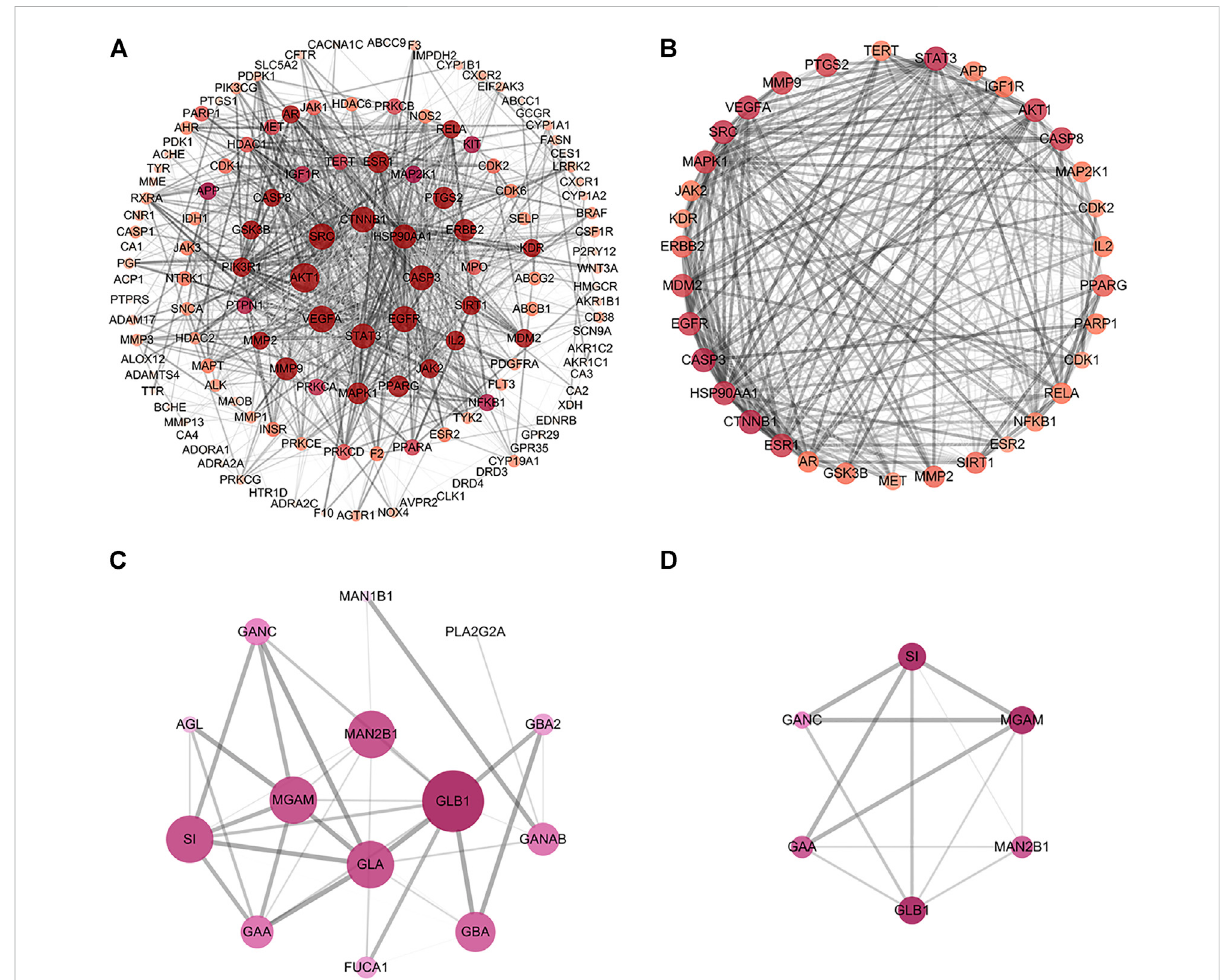
FIGURE 6 ConstructionofthePPInetworkandcoretargets. (A) ThePPInetworkofpotential proteintargetsofMLFinthetreatmentofT2DMconstructed using Cytoscape and analyzed using NetworkAnalyzer. (B) MCODE cluster generated from (A) . (C) PPI network of potential targets of RMA in the treatment of T2DM. (D) MCODE cluster generated from (C) . The depth of color represents the degree value, and the node size is proportional to the degree of